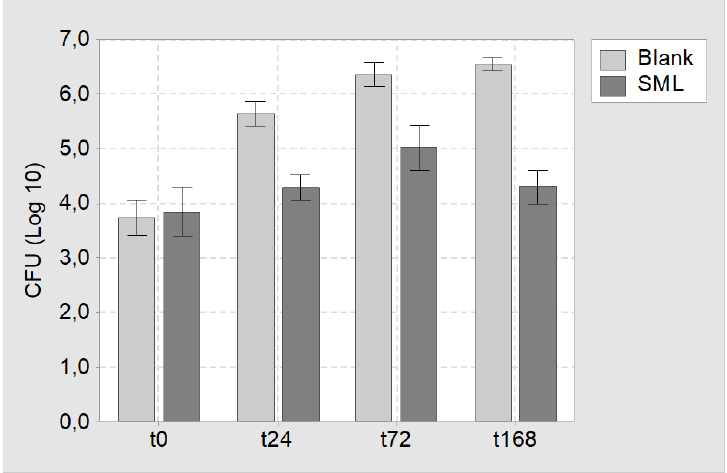
Figure 4. Results of the agar immersion test. Mean CFU count and 95% confidence interval for blank and SML coated K-wires at time point t = 0 h (t0), t = 24 h (t24), t = 72 h (t72) and t = 168 h